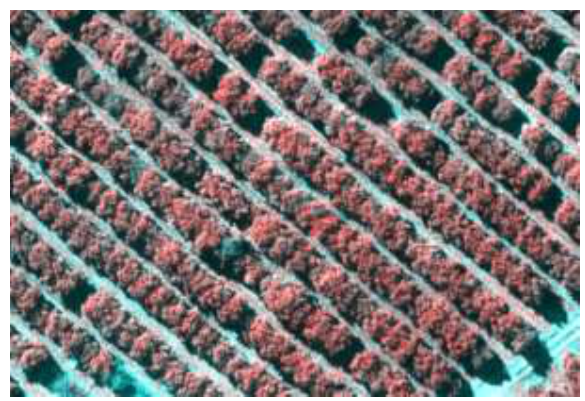
Figure 6. Color composition of HRcube: R 840.3 nm, G 519.9 nm and B 519.9 nm